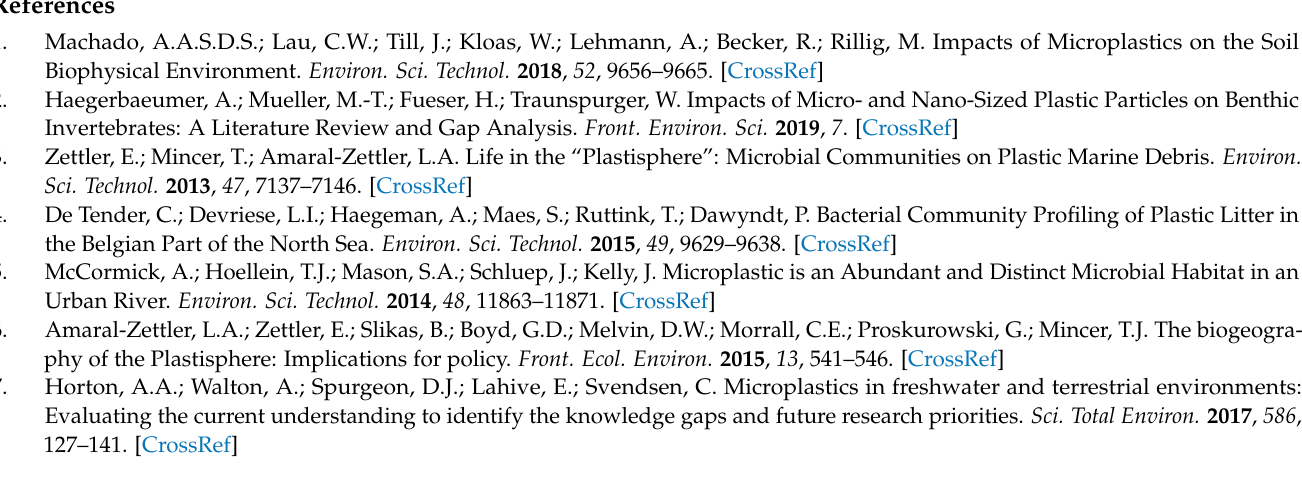
sequenced samples. Figure S2: Sampling spots of plastic debris and natural reference soil used in our study., Figure S3: Sampled material used for DNA extraction and TGA plastic quantification., Figure S4: Relative abundances of top ten most abundant ASV’s per sample type (plastic debris vs. soil)., Figure S5: Differential abundance of bacterial ASV’s., Table S1: Alpha diversity indices (mean values) of the microbial taxa present in plastic debris (plastic) and reference soil (soil) samples, Table S2: Testing homogeneity of multivariate group variances (soil versus plastic), Table S3: Two- way PERMANOVA (adonis), Table S4: Wilcoxon rank sum test for differences in abundances of Top50 ASV’s plastic debris versus soil, Table S5: Average relative abundances of Top50 ASV’s and corresponding genera in soil, Table S6: Average relative abundances of Top50 ASV’s and corresponding genera in plastic debris, Table S7: Raw relative abundances of Top50